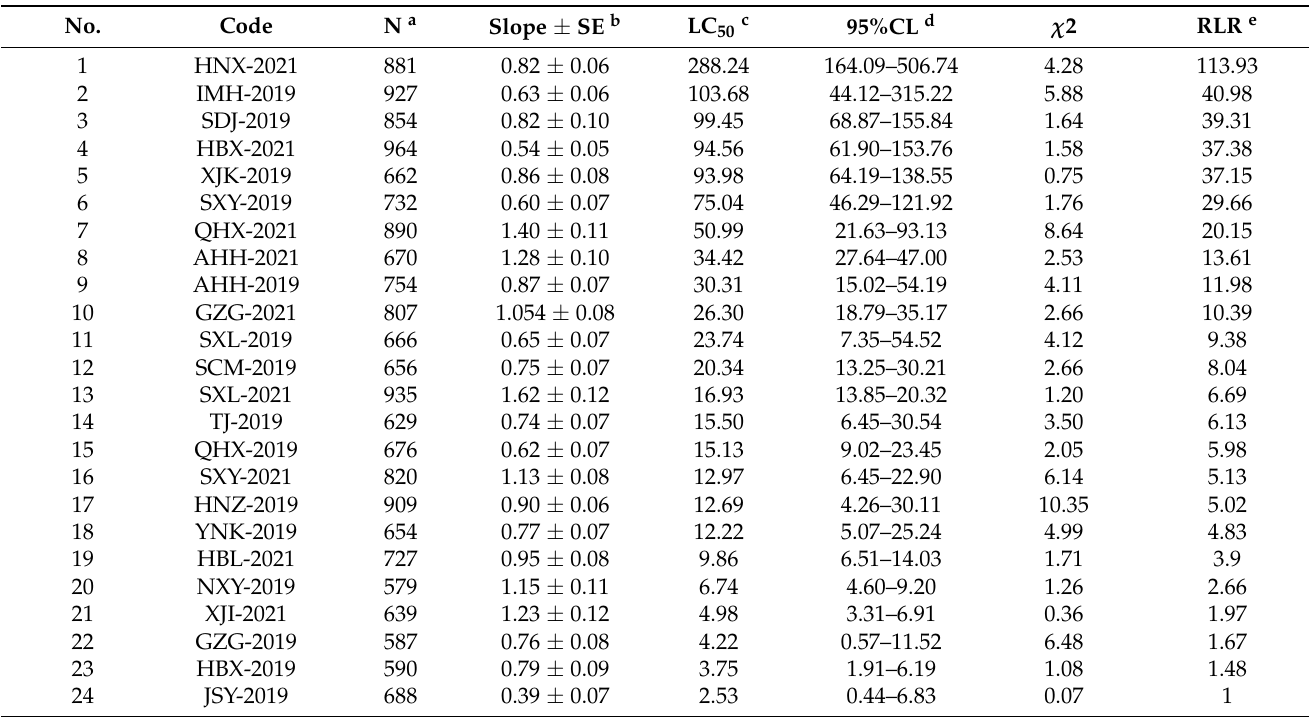
Table 2. Toxicity of sulfoxaflor to Rhopalosiphum padi field populations.